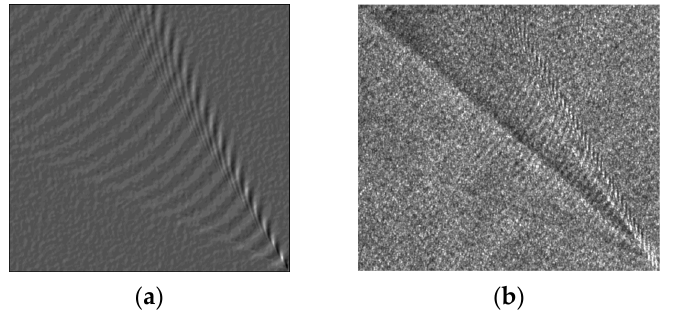
Figure 12. Comparison of ( a ) a simulated SAR image of a ship’s wake based on a semi-deterministic facet model and ( b ) a TerraSAR-X measured image.